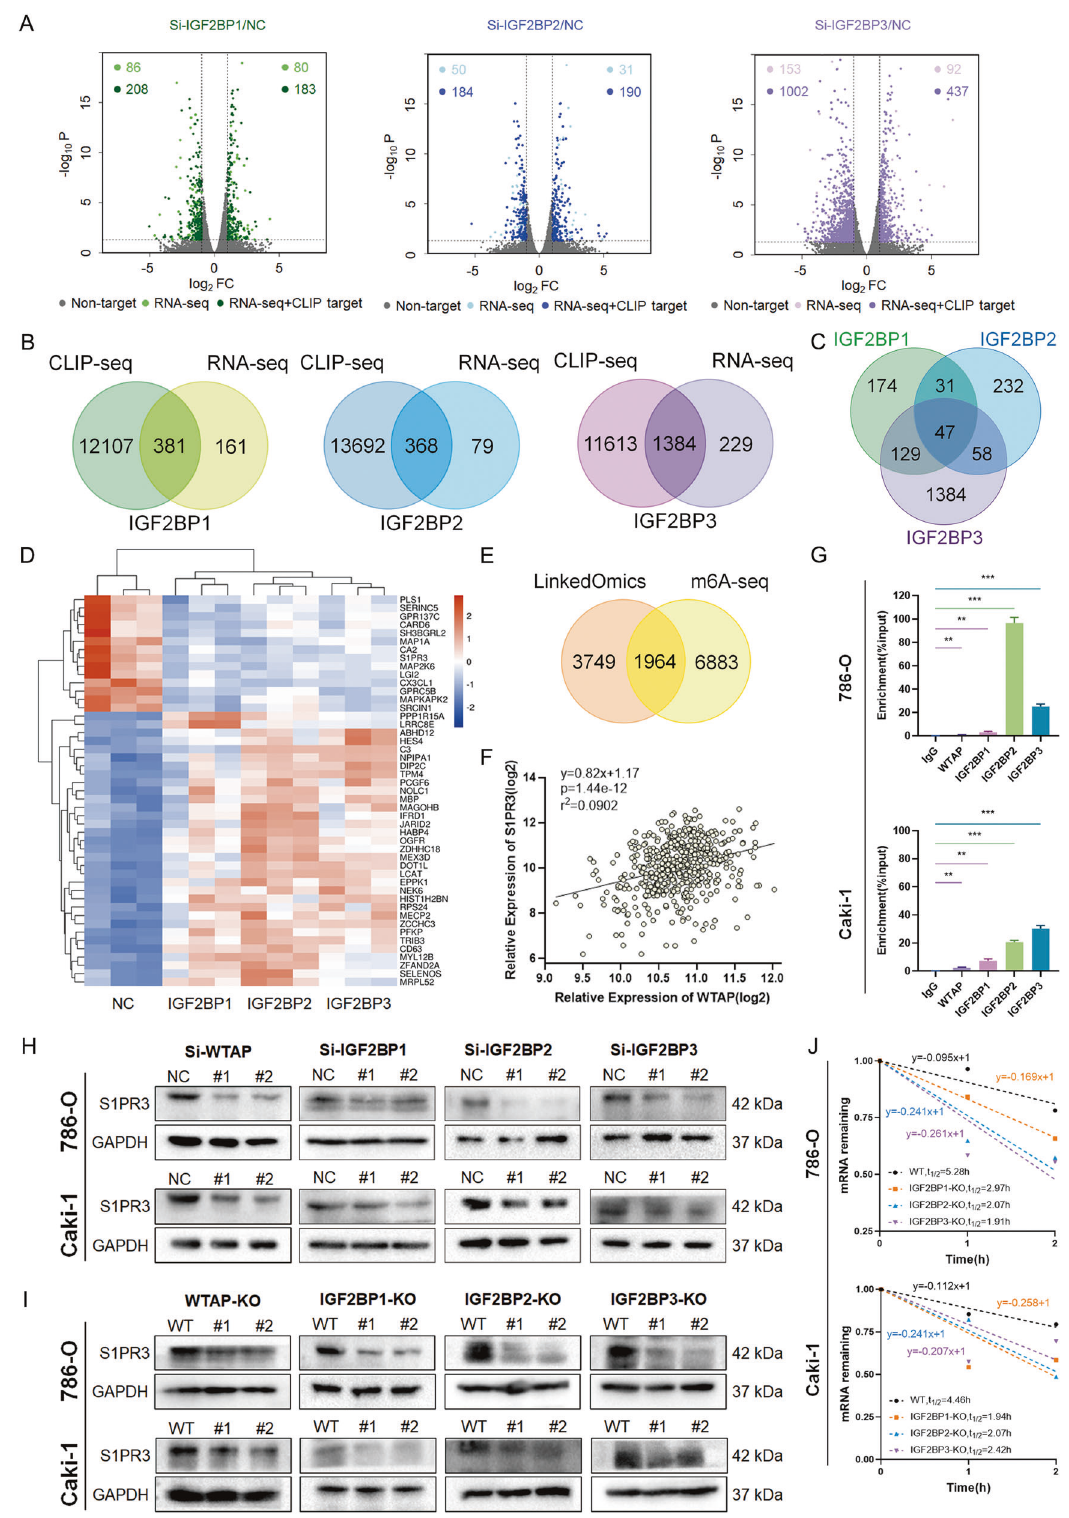
Fig. 5 S1PR3 is the downstream target of IGF2BPs and WTAP. A Volcano plots displaying enrichment of signi fi cantly differentially expressed genes in IGF2BPs knockdown vs. control 786-O cells. B Venn diagrams showing the number of overlapping genes identi fi ed by RNA-seq and CLIP-seq. C , D Venn diagrams and heat maps showing the number of overlapping genes identi fi ed by IGF2BPs knockdown. E Venn diagrams showing the number of genes identi fi ed by correlation analysis and m 6 A-seq. F Correlation analysis of gene expression levels between WTAP and S1PR3. G RIP-PCR assays showing the association of WTAP and IGF2BPs with S1PR3. H , I Either knockdown or knockout of WTAP and IGF2BPs decreased protein levels of S1PR3. J IGF2BPs knockout reduced S1PR3 mRNA half-life in RCC cells. Values in G are mean ± SEM. * P < 0.05; ** P < 0.01; *** P < 0.001.